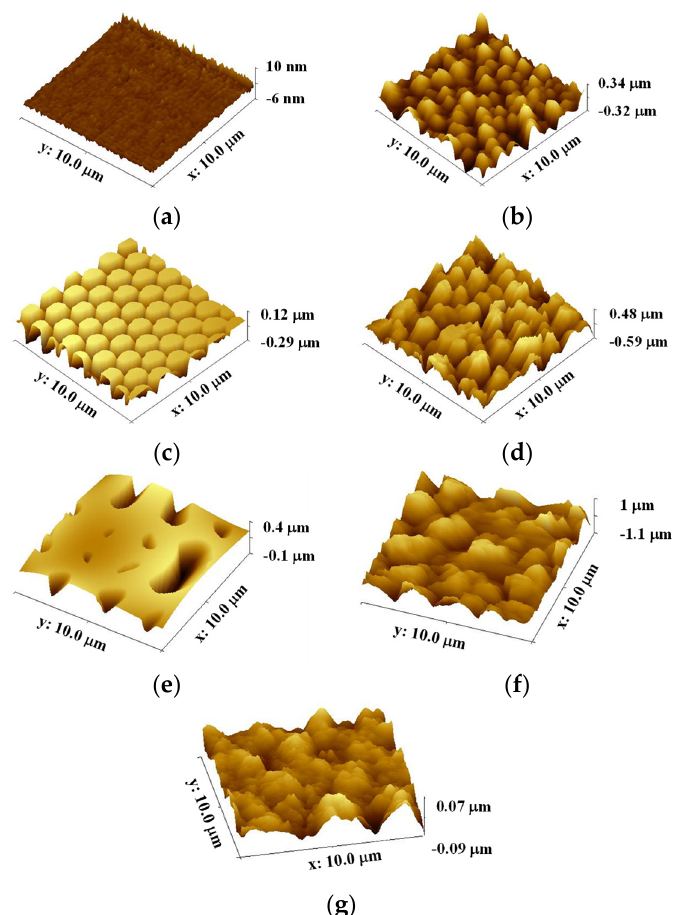
Figure 7. AFM images of untreated and flame-treated PDMS patterns and Teflon surfaces before bacterial adhesion testing: ( a ) FLT; ( b ) FLT-F; ( c ) PIL; ( d ) PIL-F; ( e ) C-RESS; ( f ) C-RESS-F; ( g ) untreated Teflon.